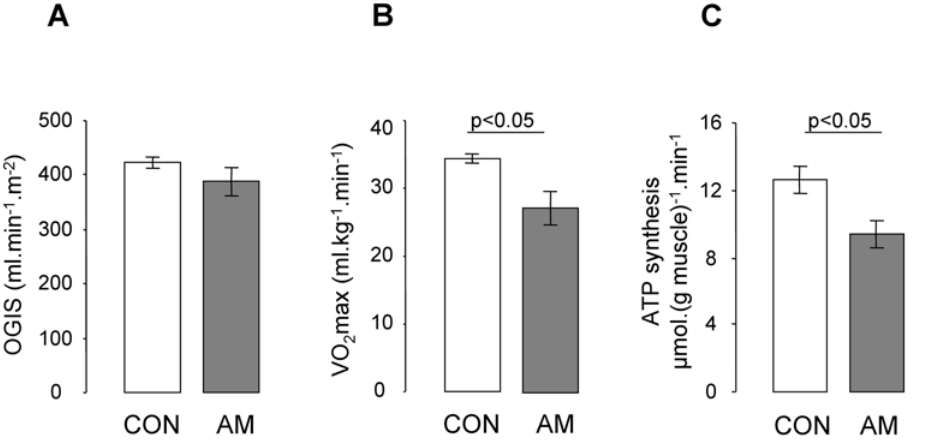
Figure 1. Whole-body insulin sensitivity, maximal oxygen consumption and muscle mitochondrial ATP production (means 6 SEM): (A) OGIS (B) VO 2 max (p , 0.05) and (C) flux through ATP synthesis (fATP) (p , 0.05) in 7 subjects with previous acromegaly (AM, full bars) and 7 age- and body mass index-matched controls (CON, empty bars).